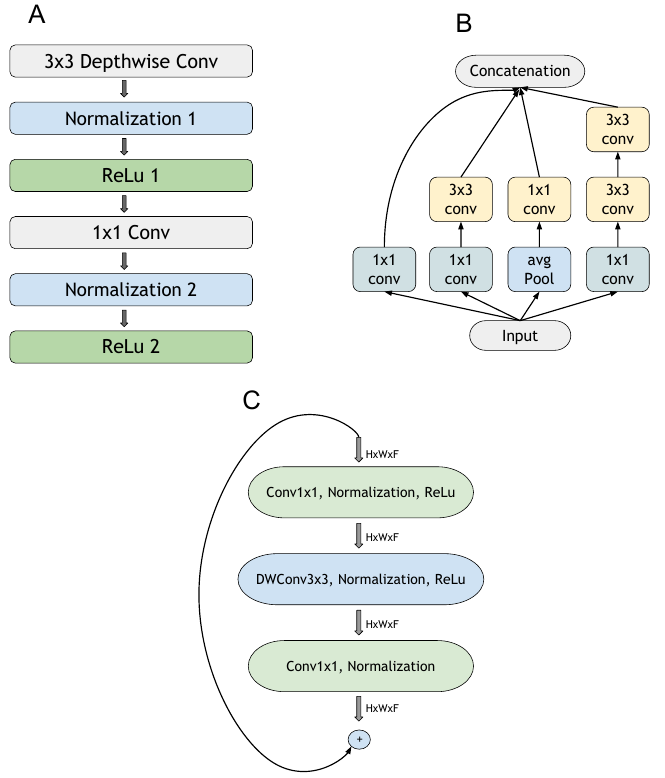
Figure 2. Main blocks of the architectures considered in this work: ( A ) MobileNet block (adapted from [35]); ( B ) InceptionNet block (adapted from [38]); ( C ) EfficientNet block (adapted from